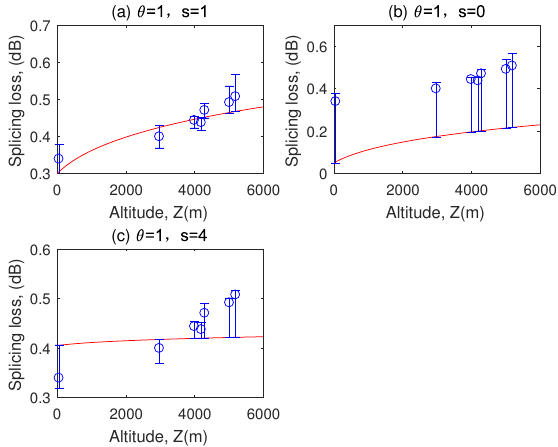
Figure 11. Splice loss versus angular tilt and lateral offset, when the inclination angle θ is 1°, the axial offset s is different, the red solid line represents the results obtained from the proposed model, and the vertical line with “ ◦ ” represents the experimental data in the environment of high altitude. The fusion experiments have been carried out at seven locations with different elevations respectively: 53 (plain), 2980, 4000, 4200, 4300, 5020, and 5200 m. After slight modification of the model, ( a ) s = 1 µ m; ( b ) s = 0 µ m and ( c ) s = 4 µ m when θ = 1 ◦